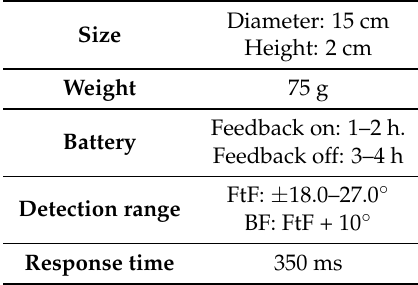
Table 2. Specification of the developed FaceLooks